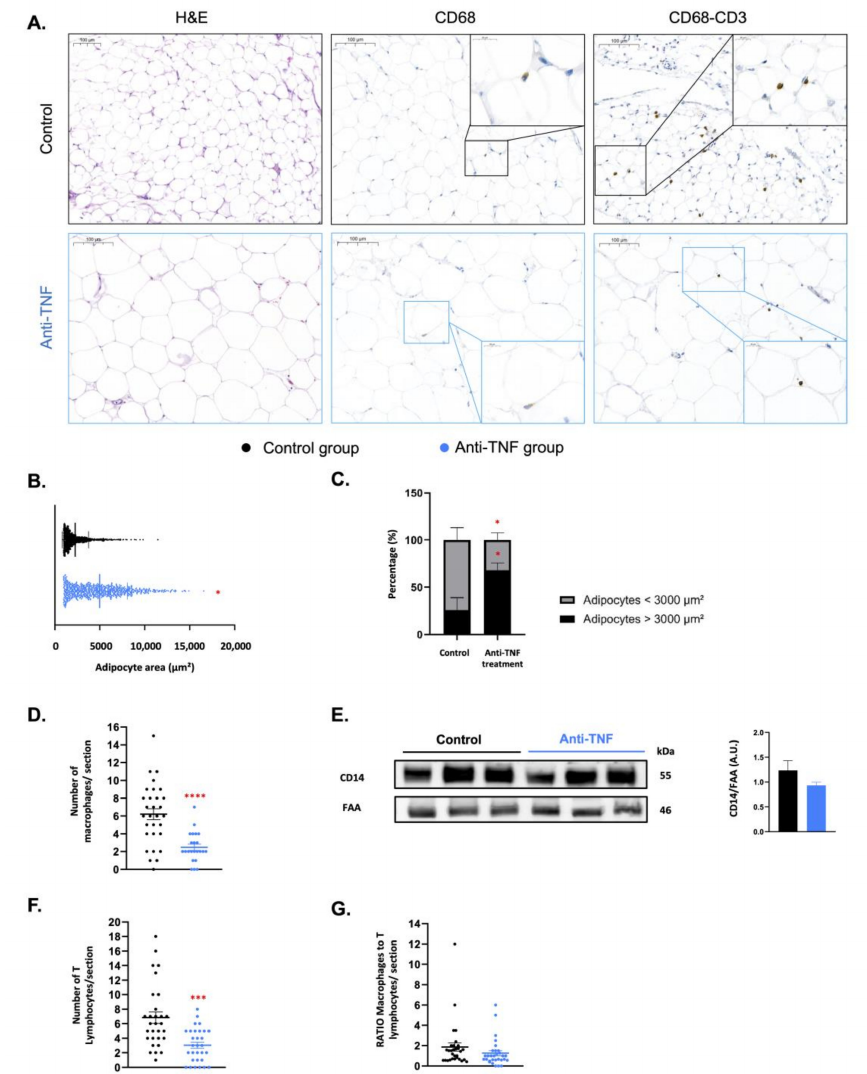
Figure 1. Anti-TNF therapy remodels adipose tissue, restoring normal adipocyte size and suppressing immune cell infiltration. ( A ) Representative histological images obtained from randomly selected 304,558- µ m 2 circular sections. Left panel: hematoxylin & eosin (H&E) staining. Central panel: CD68 immunohistochemistry (brown staining). Right panel: double CD68 (magenta stain) and CD3 immunohistochemistry (brown stain). ( B ) Adipocyte area in the creeping fat of control group and anti-TNF-treated group. ( C ) Percentage of large-size (>3000 µ m 2 ) and small-size (<3000 µ m 2 ) adipocytes detected in creeping fat. ( D ) Number of CD68-positive macrophages per section detected in creeping fat. ( E ) CD14 protein expression analyzed by Western blotting in creeping fat of control and anti-TNF-treated group. ( F ) Number of CD3-positive T lymphocytes in the creeping fat of control and anti-TNF-treated group. ( G ) Ratio of CD68- to CD3-positive cells in creeping fat. Results are shown as mean ± SEM from independent donors’ experiments. * p < 0.05, *** p < 0.001, and **** p < 0.0001 vs. control